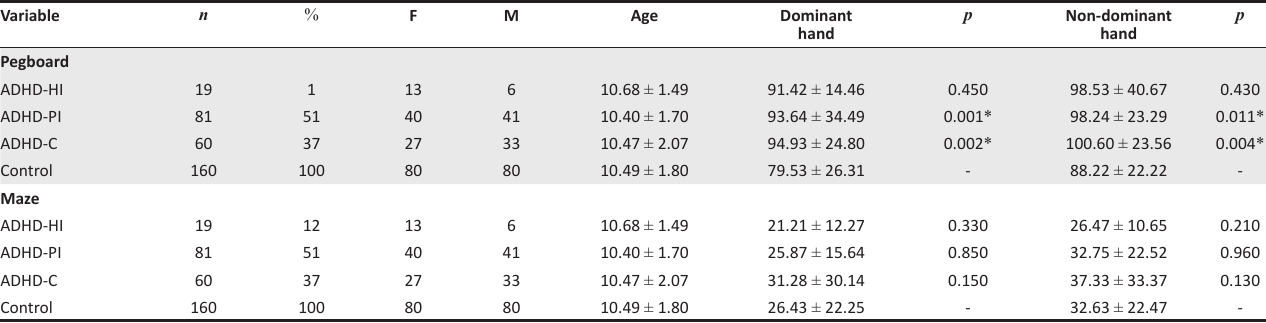
TABLE 1: Descriptive statistics and multivariate analysis of variance results for two motor tasks.